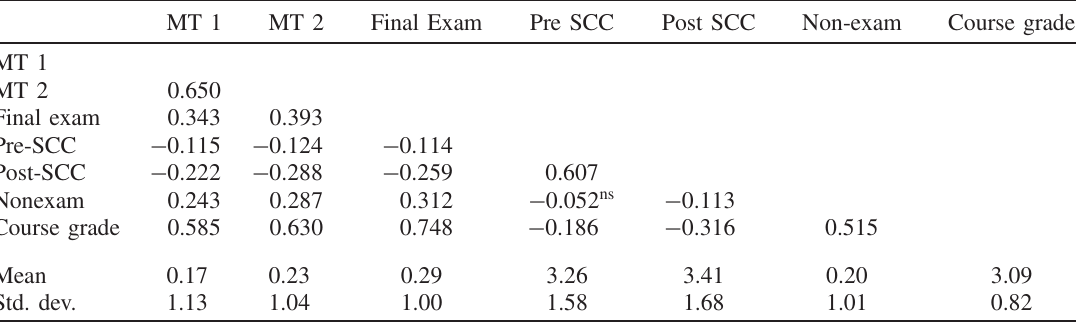
TABLE IV. Correlations, means, and standard deviations for all students with no missing values on variables ( N ¼ 392 ). The midterm, final exam, and nonexam component values are z scores ( z scores were calculated using the mean and standard deviation of all 1232 students). All values are significant at p < 0 . 05 , except for the cell marked “ ns ”